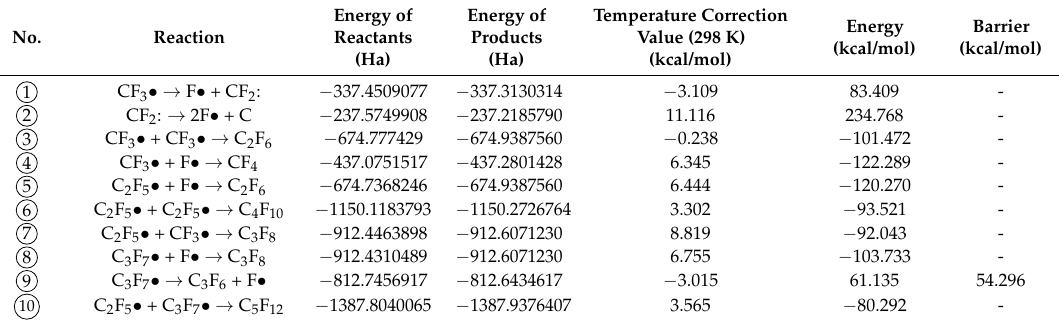
Table 2. Energy and barrier of decomposition product.